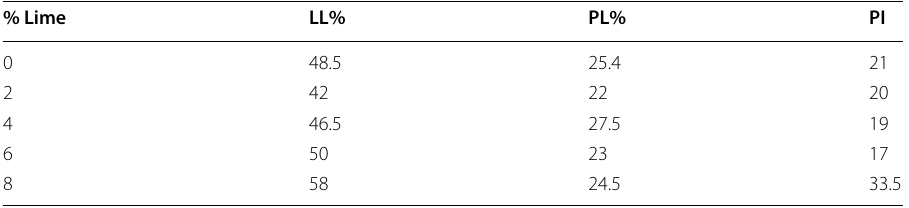
Table 4 Variation of Atterberg’s limit for soil SR treated with lime and cured for 7 days % Lime